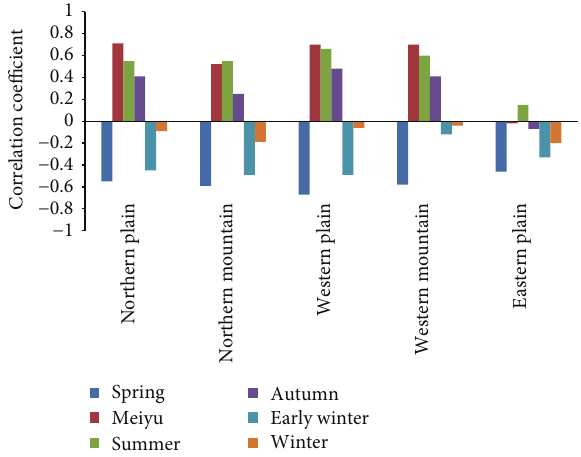
Figure 5: Correlation coefficients between rainfall anomaly and EMI at five subareas during El Ni˜no Modoki episode.